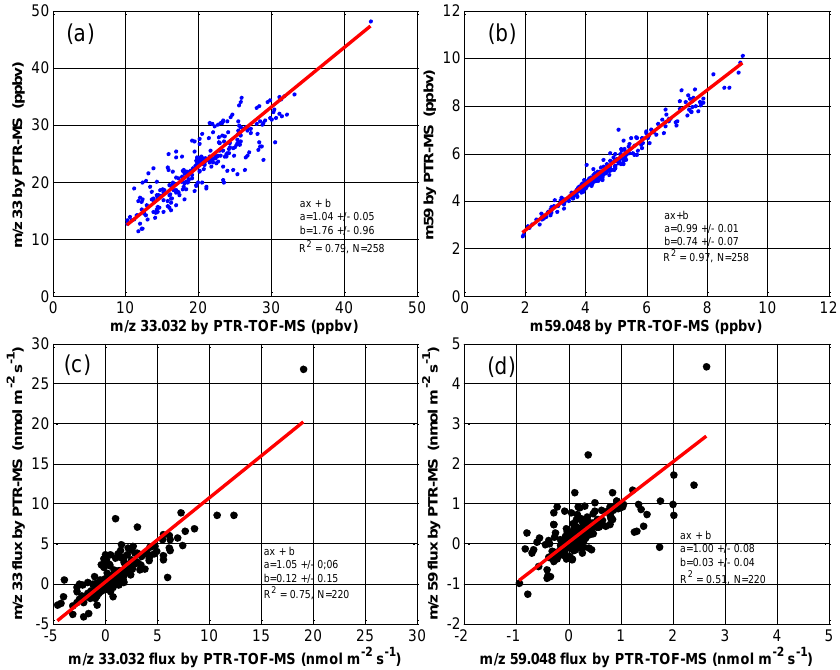
Fig. 6. PTR-MS and PTR-TOF-MS mixing ratio (a, b) and flux (c, d) inter-comparison for methanol (a, c) and acetone (b, d). Best fit is shown in red with fitting parameters given in the legends (slope, intercept and R-square).